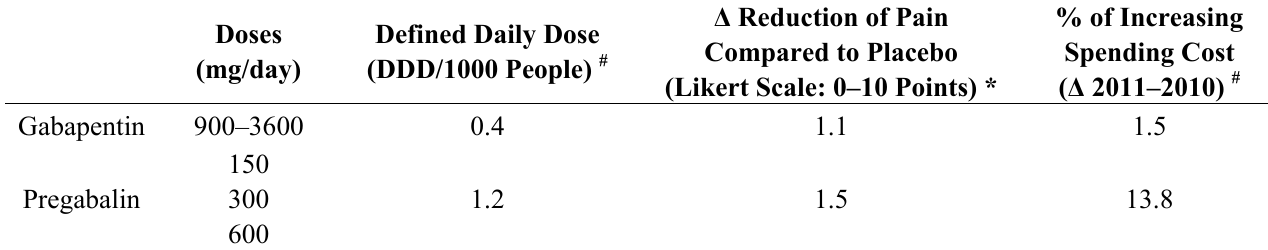
Table 2. Prospective comparison between gabapentin vs. pregabalin